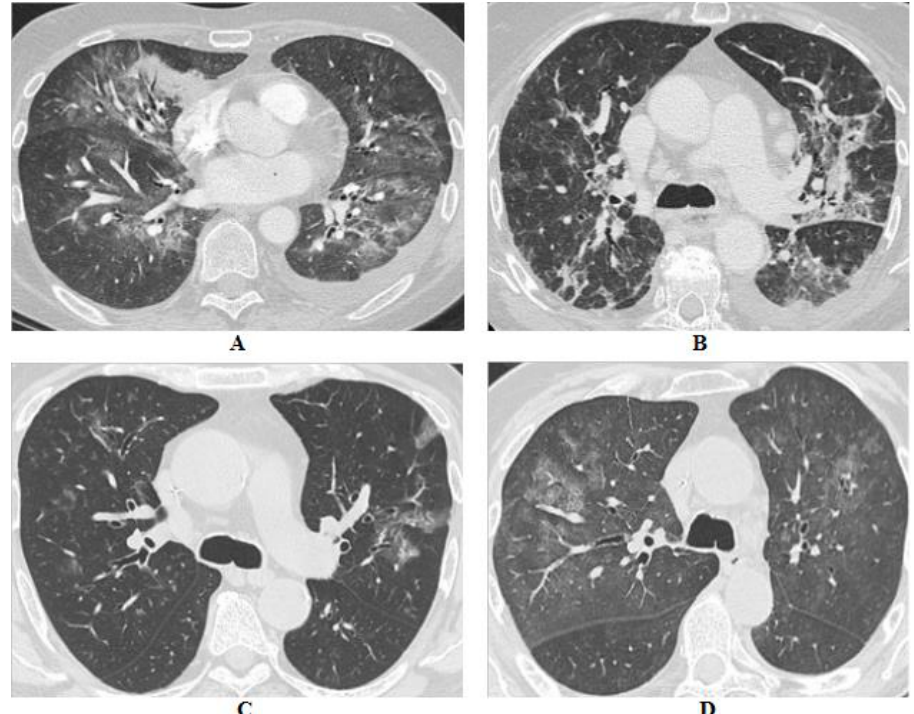
Figure 1. ( A ) 56-year-old male affected by renal cell carcinoma in treatment with everolimus, ( B ) 83-year-old female affected by esophageal adenocarcinoma in treatment with FOLFOX regimen, ( C ) 69-year-old male affected by gastric adenocarcinoma in treatment with FOLFIRI regimen, ( D ) 65-year-old female affected by pancreatic adenocarcinoma in treatment with gemcitabine. In ( A , B ) are shown multifocal consolidations, partly ground glass, in a pattern compatible with COP. In ( C , D ) scattered and patchy ground-glass opacities with crazy paving appearances, expression of alveolar damage, can be observed. All these patients were hospitalized during the COVID-19 pandemic, nevertheless, despite similar findings for both pairs, only for ( B , C ) was SARS-CoV-2 recognized as the causative agent, while for ( A , D ) chemotherapy was considered the most suspected etiology.